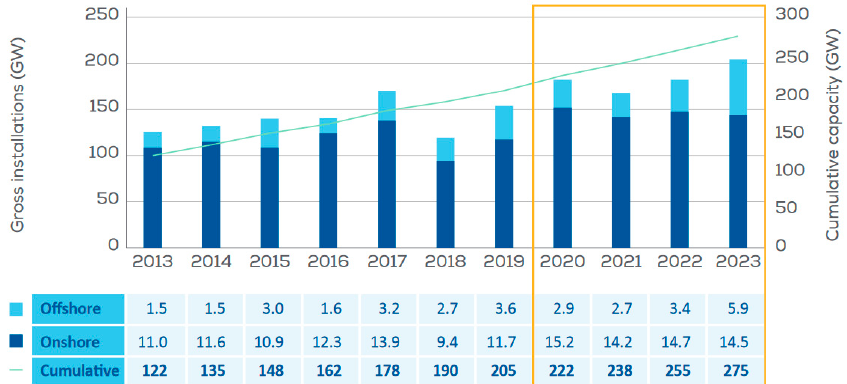
Figure 1. Gross annual wind turbine installations in Europe, reproduced with permission of WindEurope [13].